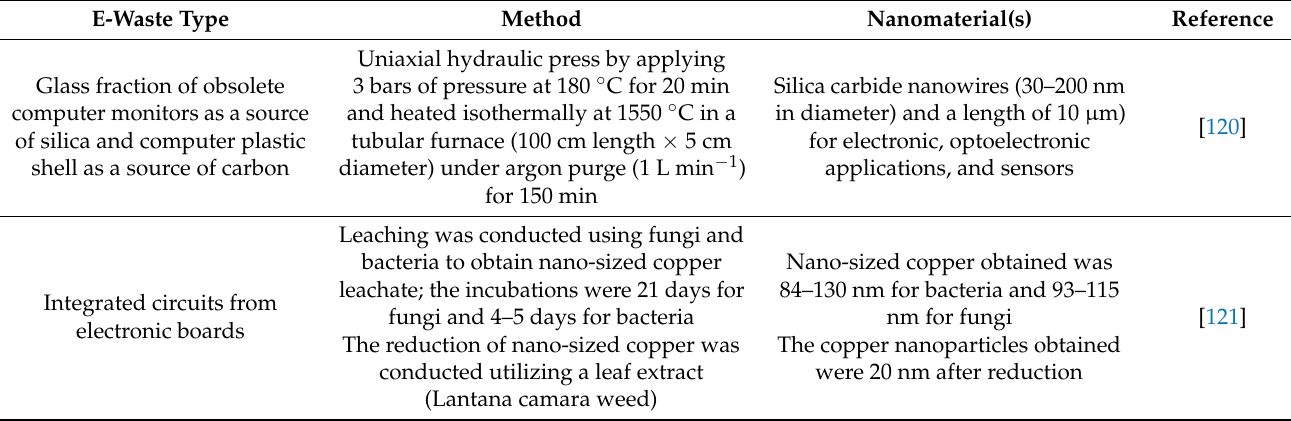
Figure 12. Conversion of e-waste to value-added nanomaterials (AgNPs as an example) [127]. Table 10. A summary of literature on conversion of e-waste to nanomaterials.